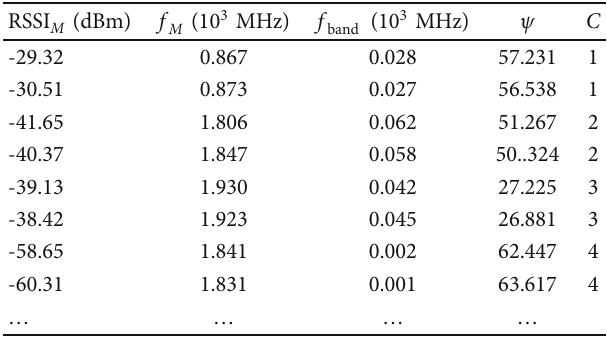
Figure 6: Spectrum normalization of four interference modes. Table 1: Partial experimental characteristic